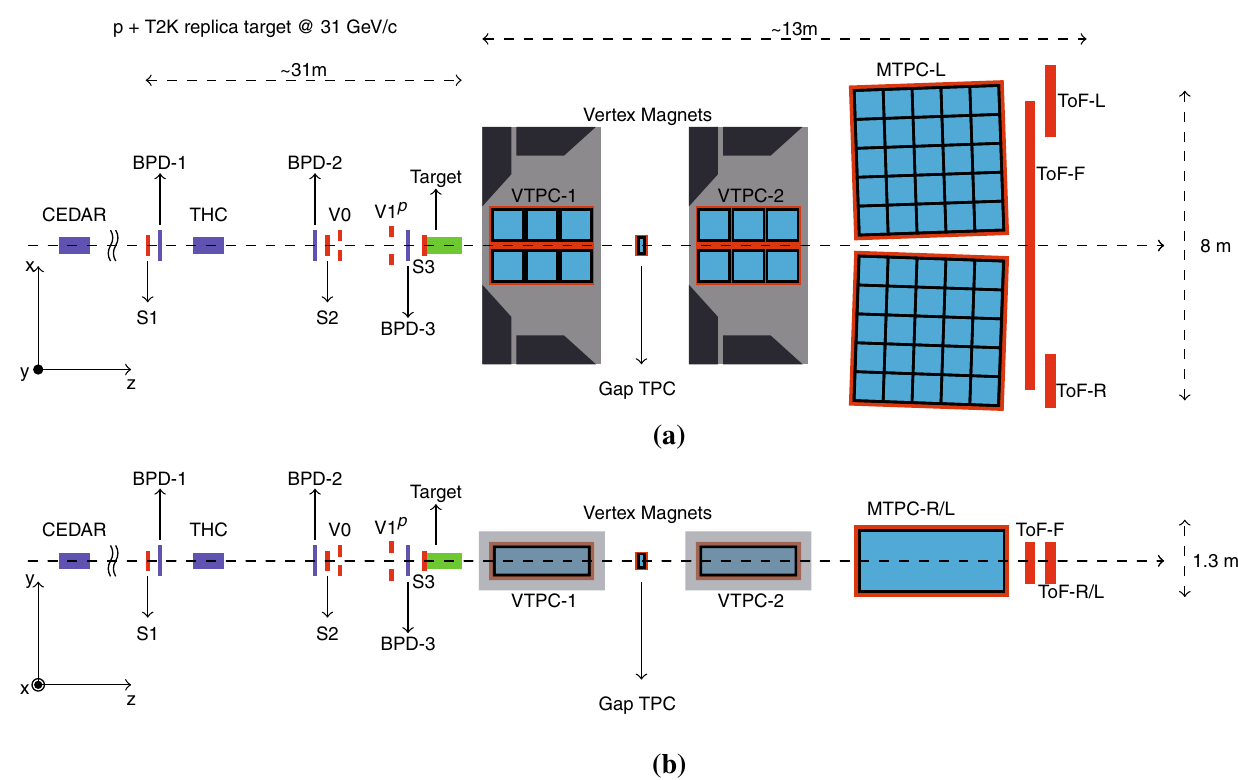
Fig. 1 A top view ( a ) and a side view ( b ) of the NA61/SHINE experimental setup used in 2010 for the T2K replica target data-taking. The beam comes from the left. The orientation of the coordinate system is shown in the bottom left corner, while its origin is located at the centre of